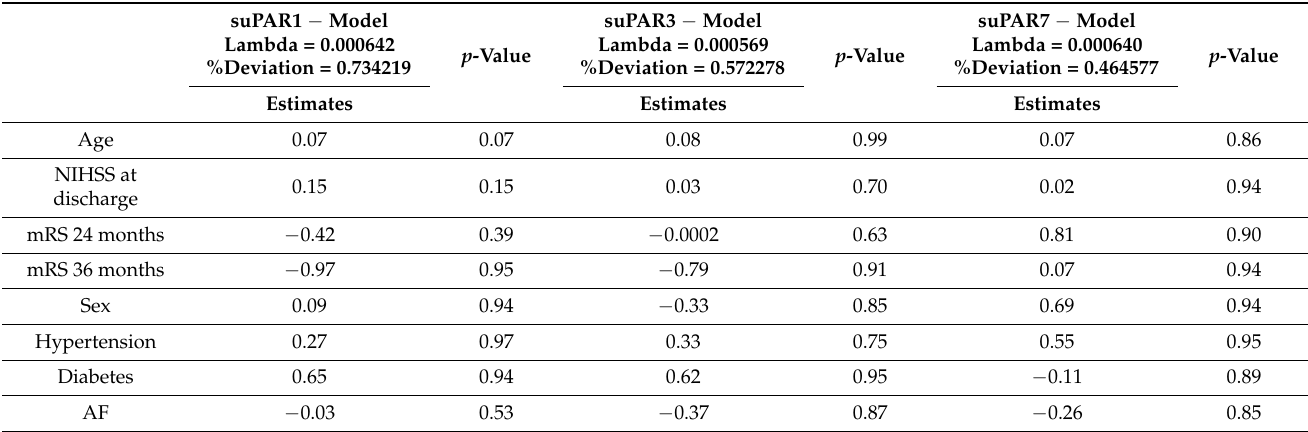
Table 4. suPAR LASSO regression models with selected clinical data and disability scales.